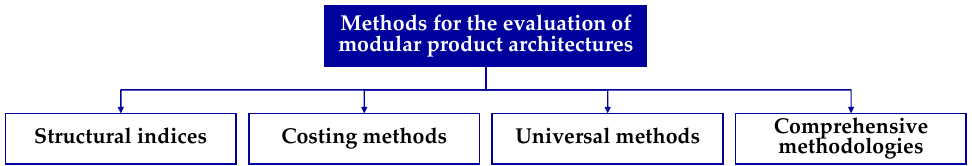
Figure 2. Categorization of methods for the evaluation of modular product architecture concepts according to [16].